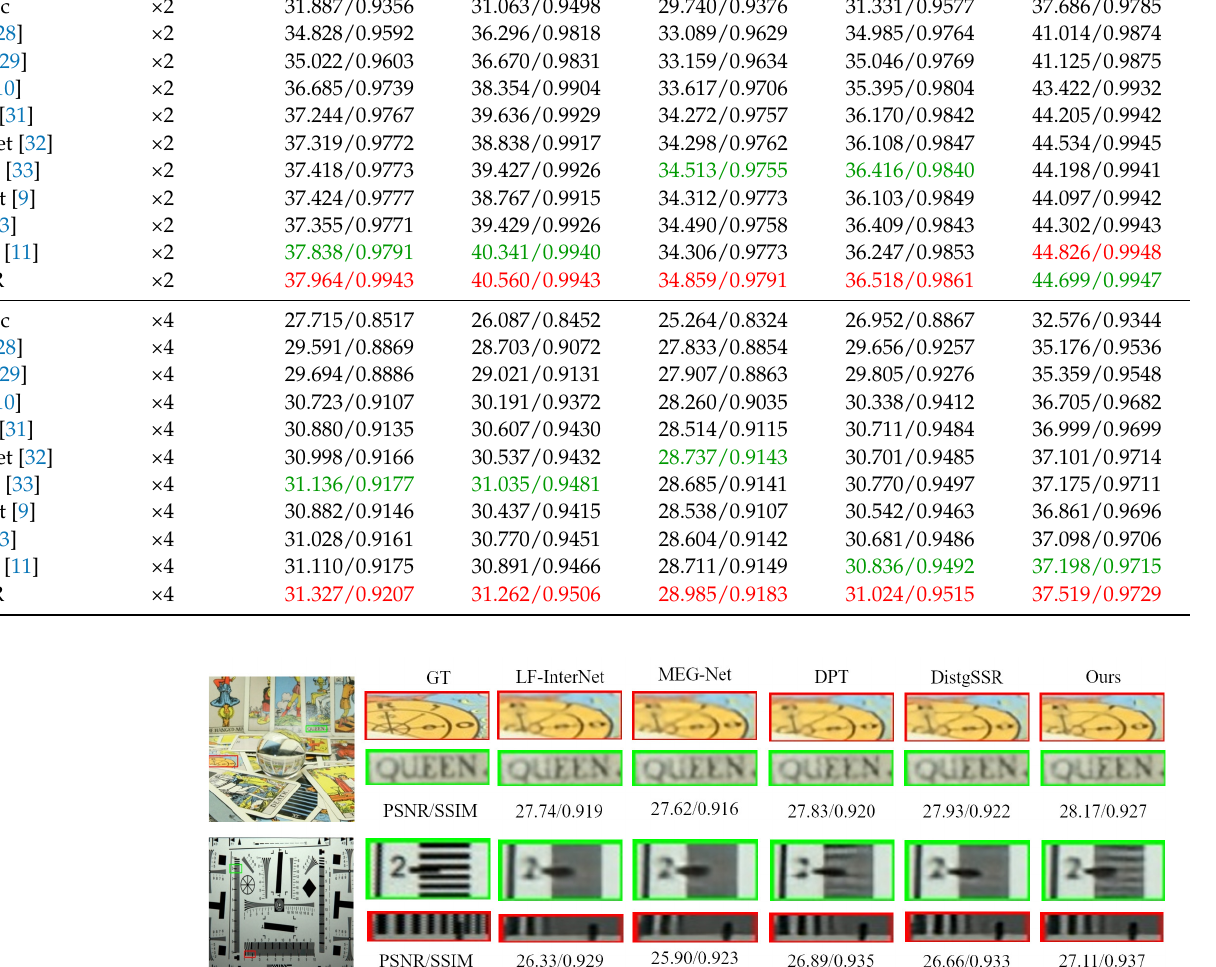
Figure 5. Comparison visualization of our MFSR and other LFSR